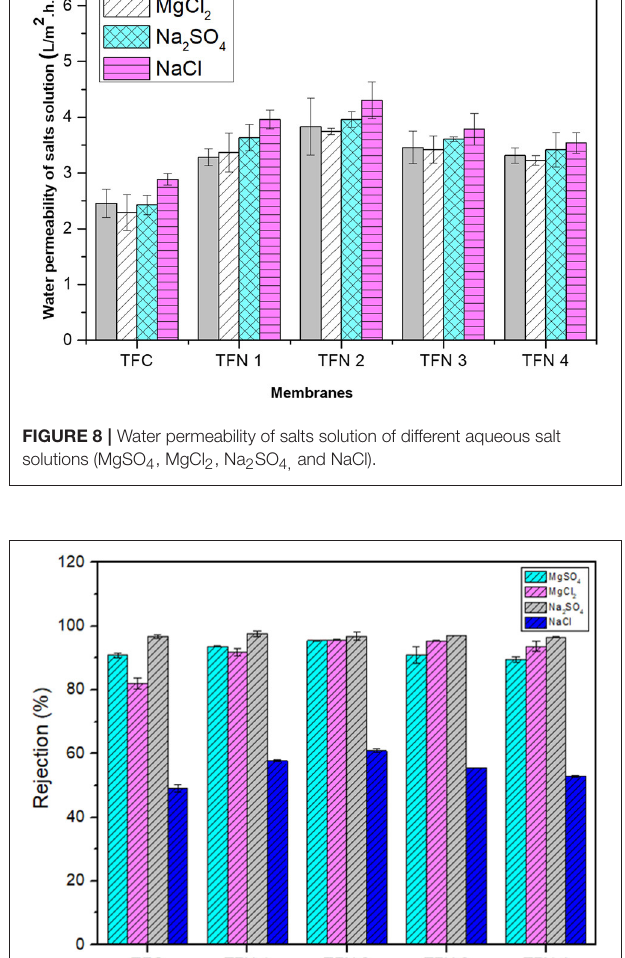
TABLE 3 | Membrane surface roughness TFC and TFN membranes. Membranes